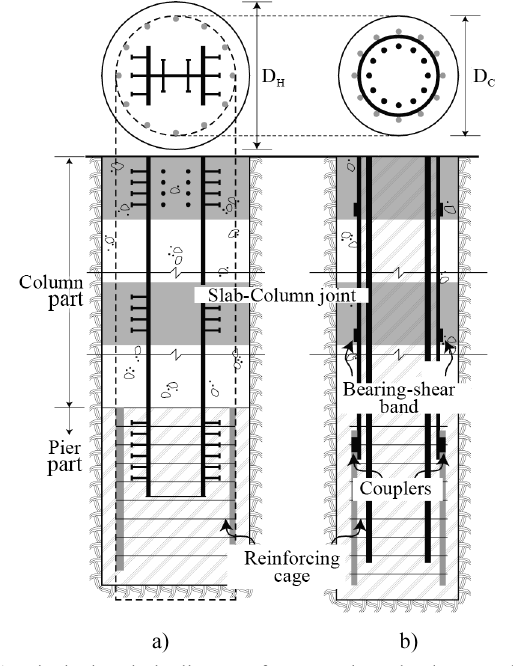
Fig. 1. Comparison of pre-founded columns based on column sections: (a) H-sections and (b) circular CFTs